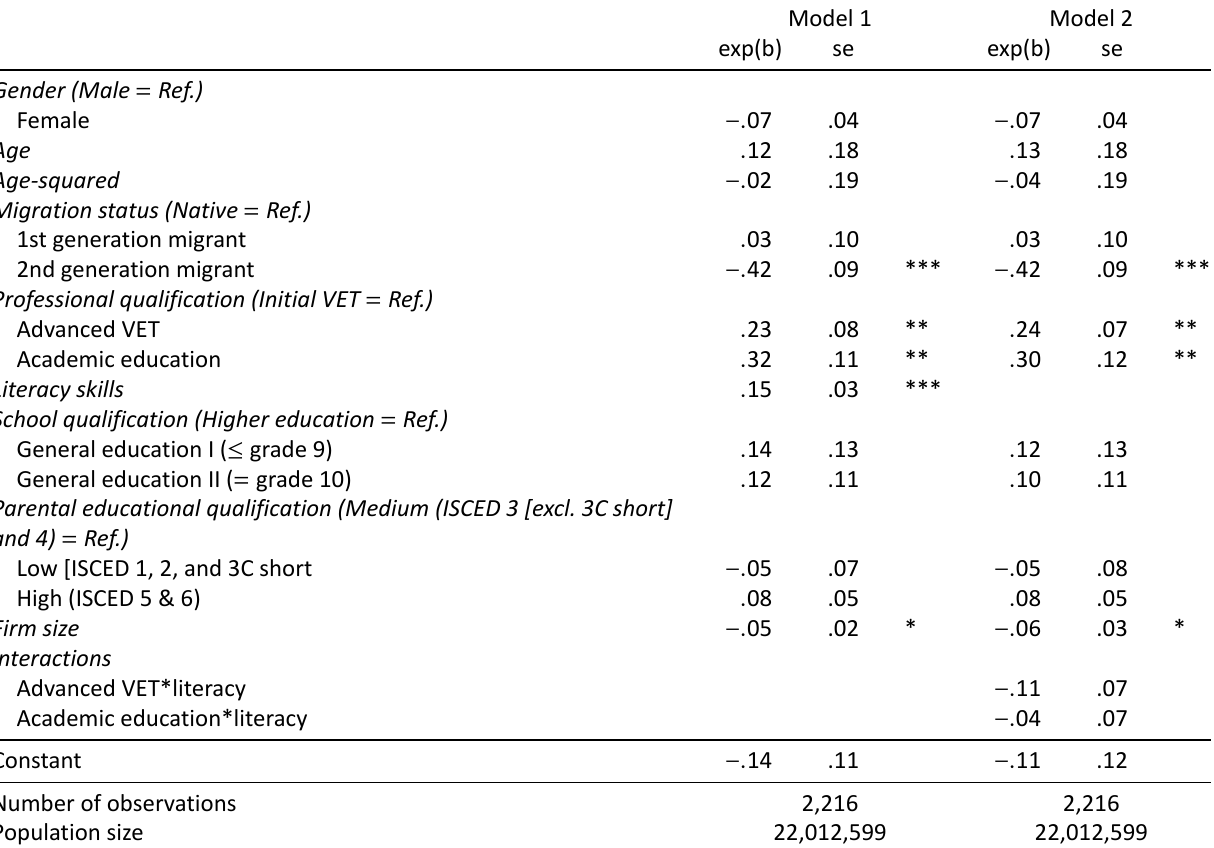
Table A2. Full regression results for job